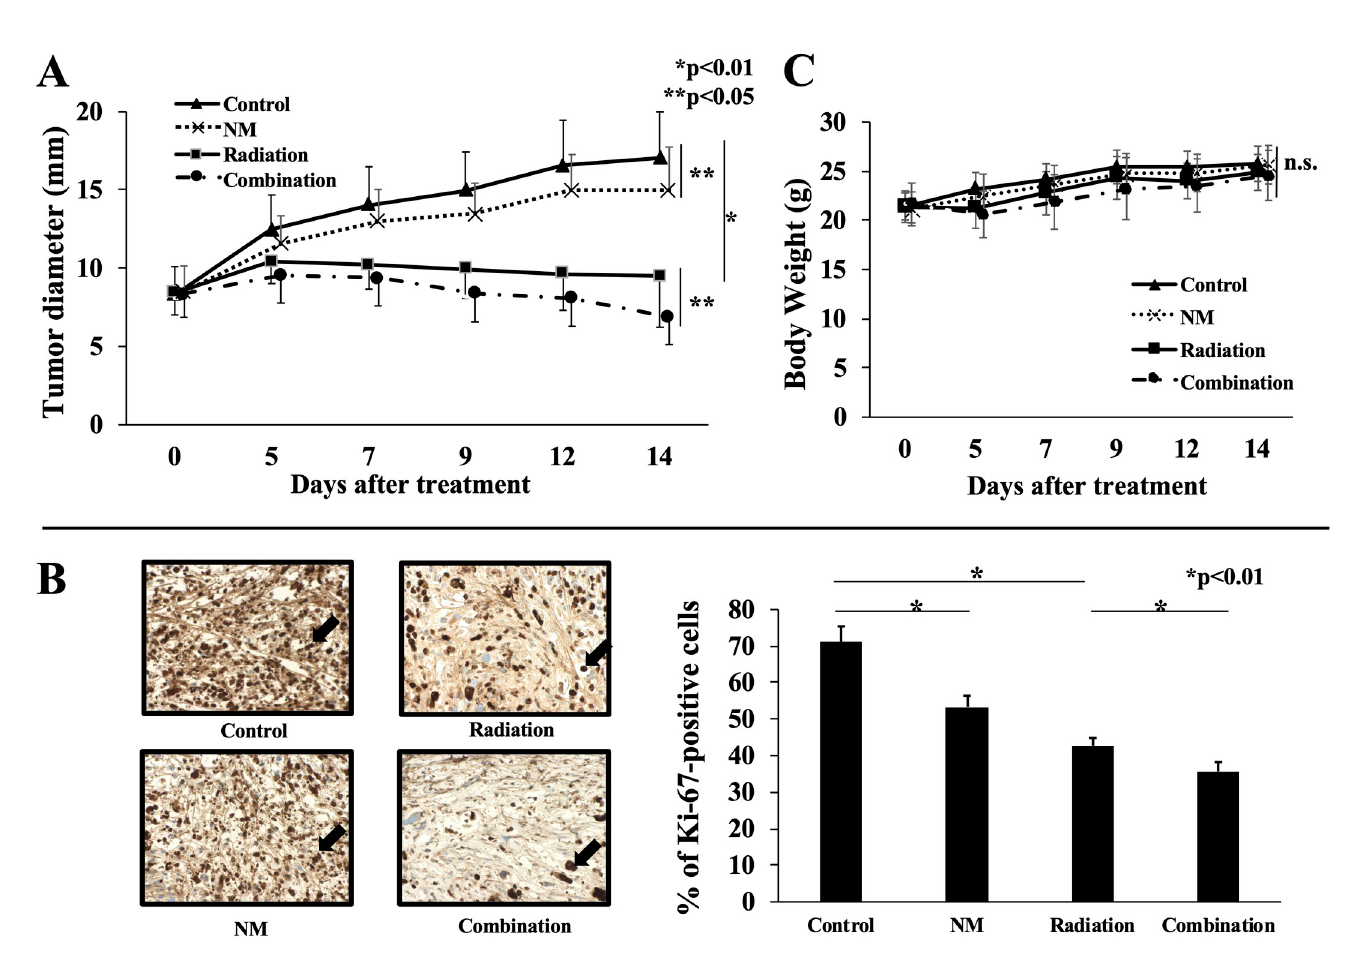
Fig 7. Growth of subcutaneous tumors in xenograft GBC mouse models. (A) At two weeks after treatment, the tumor diameter in the combination group was smaller than that in the radiation group (6.7 ± 1.8 mm vs. 9.5 ± 3.3 mm, p < 0.05). In addition, the tumor diameter in the NM group was suppressed compared with that in the control group (14.8 ± 2.8 mm vs. 17.1 ± 2.9 mm, p < 0.05). (B) Immunohistochemical staining showed that the percentage of Ki-67-positive cells in the combination group was lower than that in the radiation group (35.7 ± 2.6% vs. 42.7 ± 2.2%, p < 0.01). Ki-67-positive cells are indicated with arrows (400 × ). (C) Body weights of mice in the four groups were comparable during the treatment